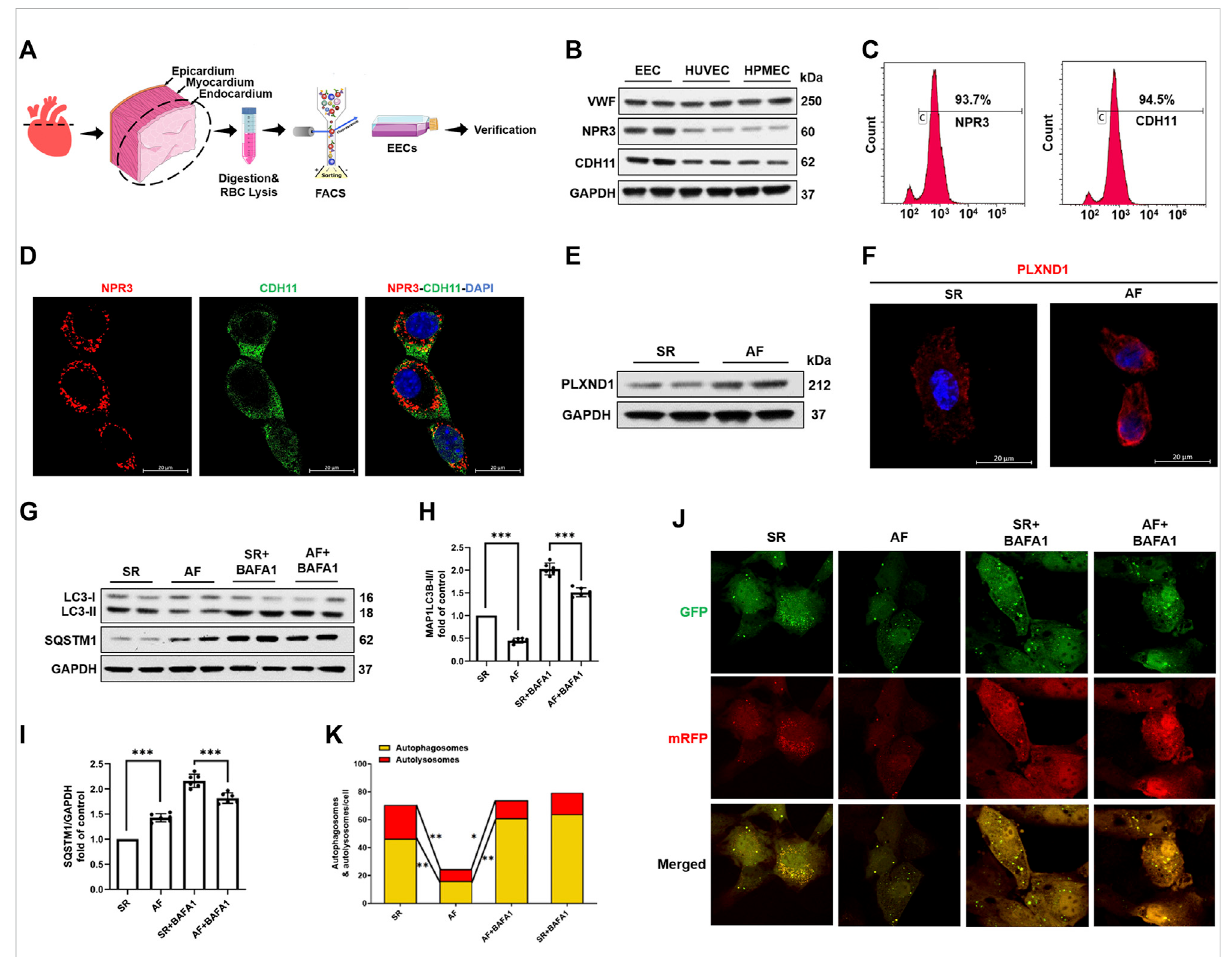
FIGURE 2 Atrial fi brillation promotes PLXND1 expression and inhibits autophagy in endocardial endothelial cells. (A) Diagram of the EEC isolation from SR andAFmice. (B) Veri fi cationwithspeci fi cmarkers(NPR3andCDH11)inEECscomparedtothoseinHUVECsandHPMECsbyWBdata. (C) Veri fi cation with speci fi c markers (NPR3 and CDH11) in EECs compared to those in HUVECs and HPMECs by FACS. (D) Immunostaining data verifying the colocalization of EEC marker NPR3 (red)and CDH11 (green) in EECs. (E) Representative WBand quanti fi cation of PLXND1 in EECs isolated from SR and AF mice. (G – I) Representative WB and quanti fi cation of autophagy-related protein levels of EECs subjected to BAFA1 (100 nM) treatment or no treatment. (J) EECs from SR and AF mice were infected with a tandem GFP-mRFP-LC3 adenovirus for 24 h. Representative images show formation of puncta in different groups. Scale bar: 10 μ m. (K) Quantitative analysis of yellow and free red puncta in merged images. The number of bothyellowandfreeredpunctadecreasedintheEECsofAFmicecomparedtothatinSRmice.( n =10cellspergroup;cellswereisolatedfromthree miceforoneexperimentandthreeindependentexperimentswereperformed;mean±SD;* p < 0.05,** p < 0.01).EECs,endocardialendothelialcells; SR, sinus rhythm; AF, atrial fi brillation; HUVECs, human umbilical vein endothelial cells; HPMECs, human pulmonary microvascular endothelial cells; FACS, fl uorescence-activated cell sorting; NPR3, natriuretic peptide receptor 3; CDH11, cadherin 11; WB, western